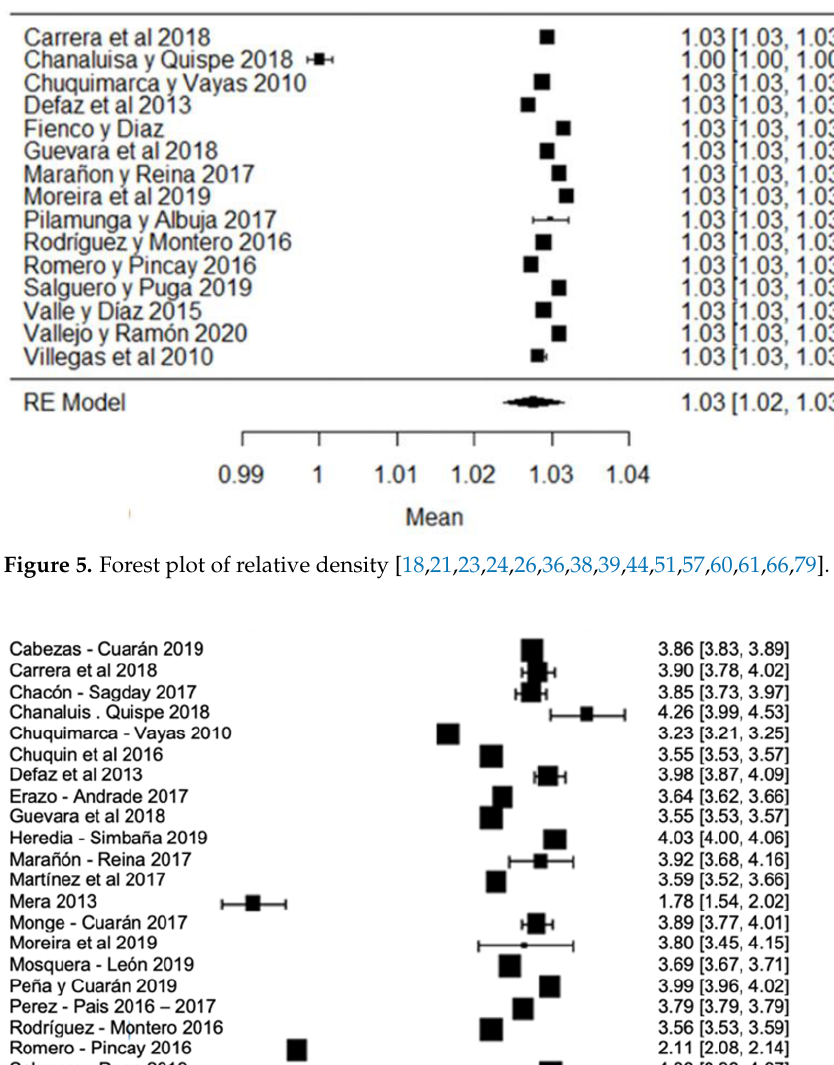
Figure 7. Lactose forest plot [42,51,57,77].